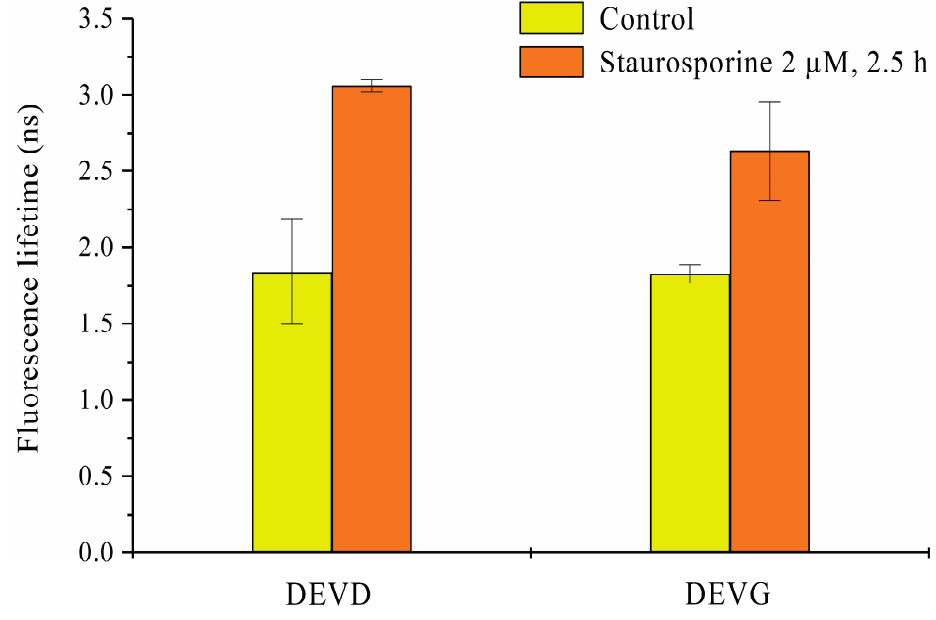
Figure 5. Fluorescence lifetime of the donor ECFP in transfected HeLa multicellular spheroids prior to and subsequent to application of staurosporine (2 µM, 2.5 h). Medians ± median absolute deviations (MADs) of six cell layers (from three spheroids) each selected by light sheet based fluorescence microscopy. Excitation wavelength: 391 nm; fluorescence detected at 450–490